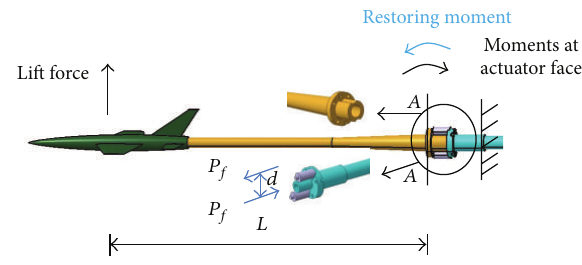
Figure 1: Sting-damping actuator design concept.